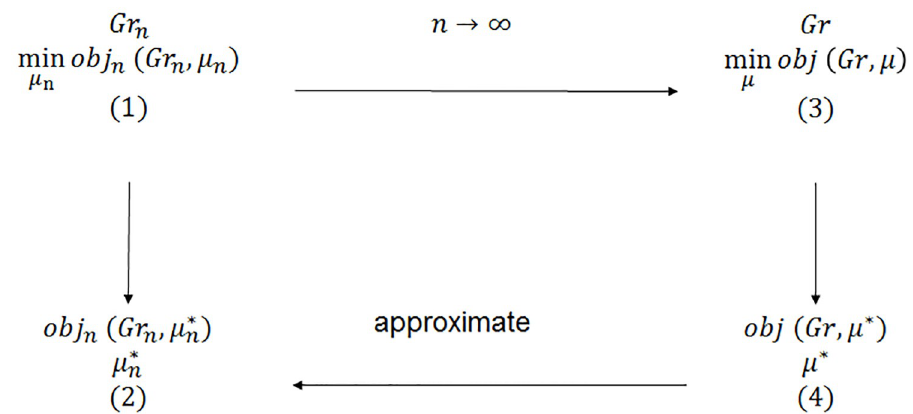
Fig 1. The methodology : Approximation of the finite network with the infinite network.